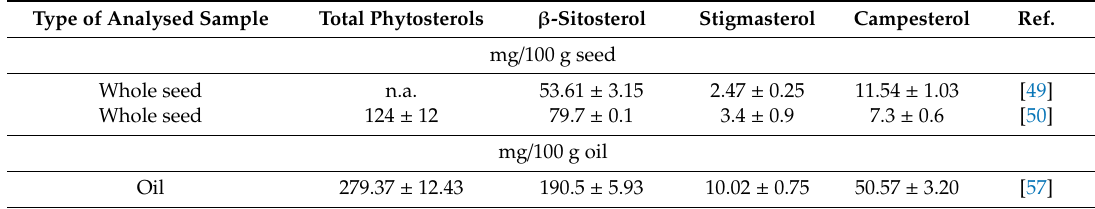
Table 5. Hempseed oil unsaponifiable matter: phytosterol